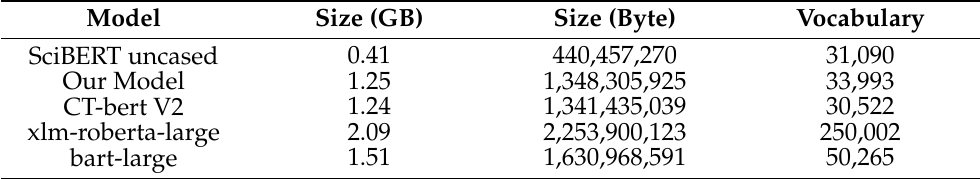
Table 9. Comparison of model and vocabulary size.